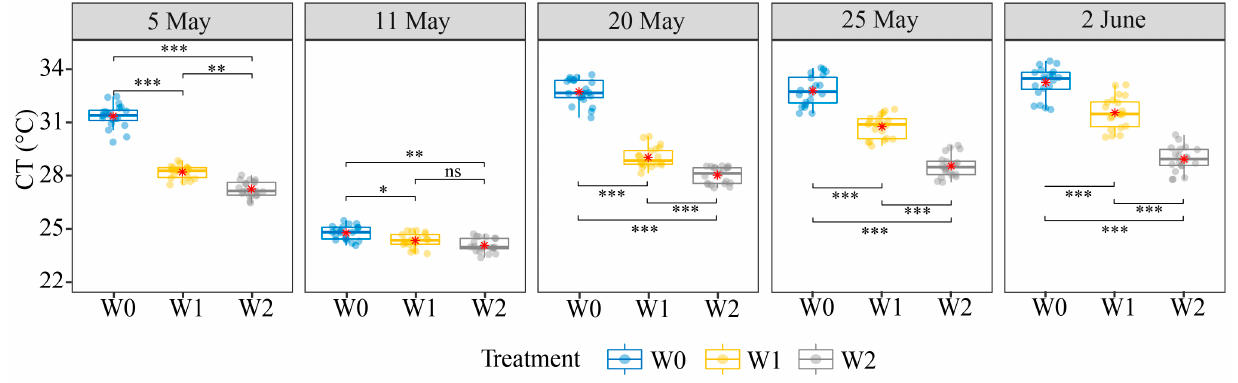
Figure 6. Canopy temperature based on UAV thermal imagery at different stages under W0, W1 and W2 treatment. The red “*” represents the mean value of the canopy temperature. In addition, the horizontal lines in the boxes in the two figures represent the median, and the dots represent the canopy temperature values of different plots. The significance analysis is based on the t -test method, 0.01 < p < 0.05, is “*”, 0.001 < p < 0.01, is “**”, p < 0.001, is “***”. The relatively low CT on 11 May was due to the precipitation before the measurement date. Figure 7 shows the canopy temperature difference between varieties on 20 May. For the W0 treatment, there were apparent differences in canopy temperature among wheat varieties, in which JM418 and ZM1062 had lower canopy temperatures of 31.4 ◦ C and 31.8 ◦ C, respectively, while SN086 and ND3636 had higher canopy temperatures, 33.5 ◦ C and 33.6 ◦ C. For the W1 treatment, the canopy temperature differences among wheat vari- eties were still large, in which JM418, H4399 and SN086 all had lower canopy temperatures. GY5766 and ND3636 had higher canopy temperatures, 29.7 ◦ C and 30.2 ◦ C. For the W2 treatment, JM418 varieties had a lower canopy temperature that was 27.4 ◦ C and GY5766, GY2018 and SM22 varieties had a higher canopy temperature of 28.5 ◦ C. Moreover, in W0, W1 and W2 treatments, the maximum canopy temperature difference among wheat varieties was 2.2 ◦ C, 1.9 ◦ C and 1.1 ◦ C,